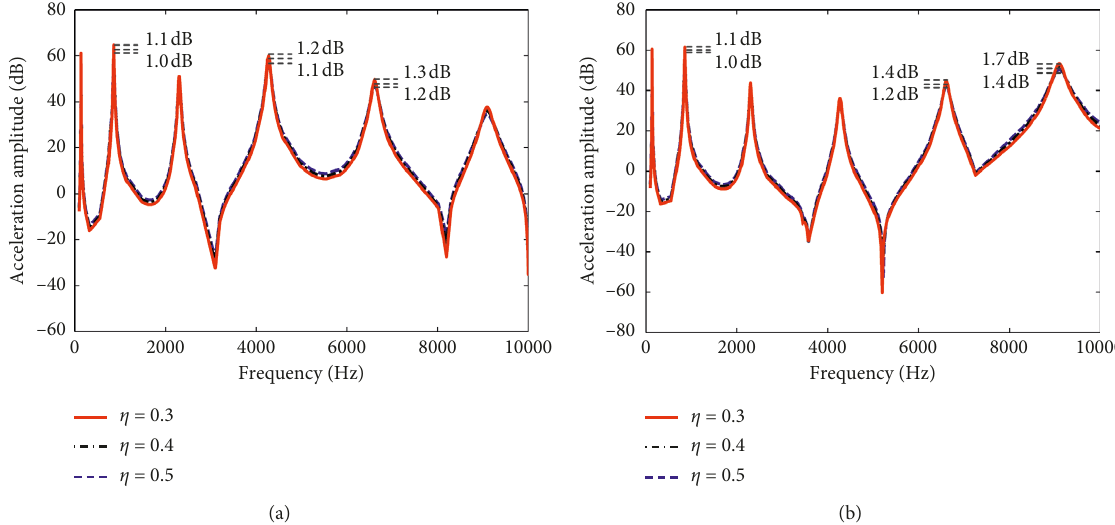
Figure 8: Effects of the damping loss factor of the damping layers on acceleration responses: (a) ABH region ( x beam region ( x m � 10 . 87 cm).